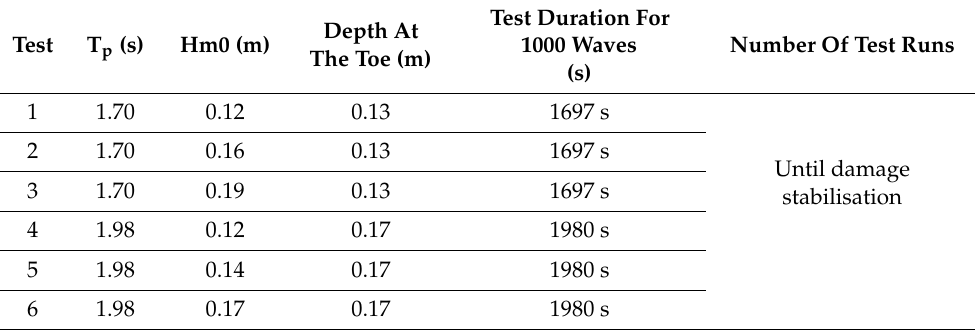
Table 1. Water levels and wave conditions considered for damage evolution for test series